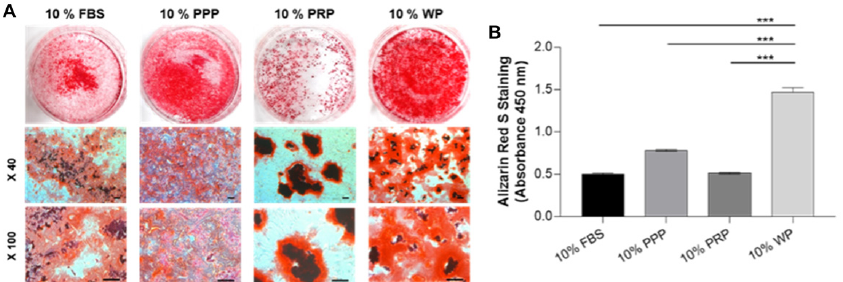
Figure 4. Semi-quantitative analysis of Alizarin Red S staining in cultured rSVFs at passage 1. ( A ) Optical microscopic images at 3 weeks showed the most mineralization in the SVF treated with WP and ( B ) quantitative results of retention of Alizarin Red S corresponding to the previous phenotype data, PPP: platelet-poor plasma, PRP: platelet-rich plasma, WP: whole plasma, scale bar: 200 µ m, *** p < 0.001 by Mann–Whitney U test.